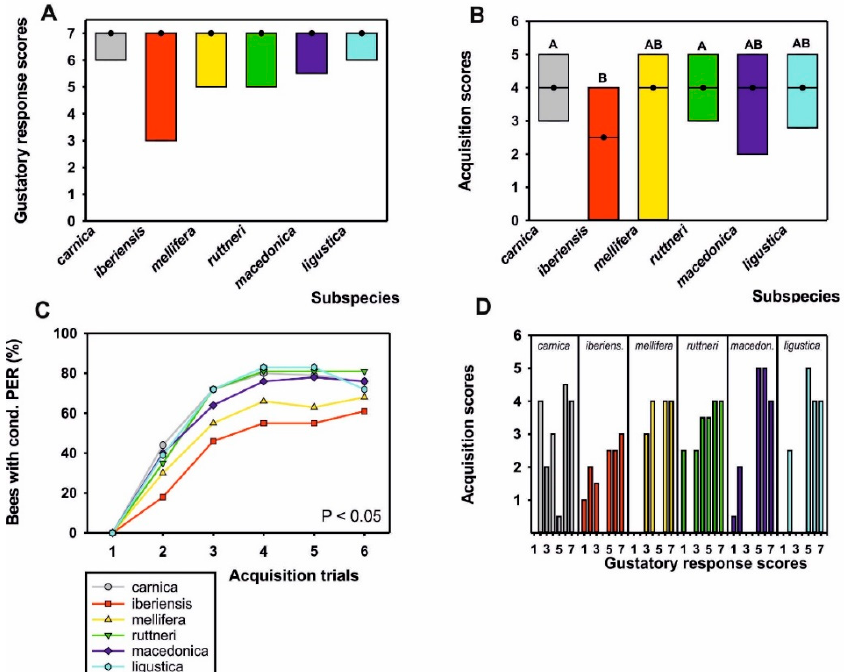
Figure 3. ( A ) Sucrose responsiveness measured as gustatory response scores (GRS) of foragers belonging to the six different honeybee subspecies trained in this study. Median GRS (dots) and quartiles (25%: lower line, 75%: upper line) are presented. Subspecies were all highly responsive to sucrose and did not differ in their GRS ( p > 0.05). ( B ) Median acquisition scores (dots) of bees from subspecies trained in classical olfactory conditioning and quartiles (see A ). Subspecies that differed significantly have different letters (for details see Table S2). ( C ) Acquisition curves of subspecies based on individual responses to the conditioned odor in each of the 6 training trials. There was a significant effect of subspecies on learning performance ( p < 0.05), with A. m. iberiensis foragers performing significantly more poorly than those of A. m. carnica and A. m. ruttneri (for details see Table S3). ( D ) Correlation between GRS and acquisition scores in each subspecies. Median acquisition scores are shown for bees in each GRS class. Different subspecies are indicated by colors. Generally, the higher the GRS, the higher was the acquisition score, demonstrating a better learning performance. For the number of bees tested see Table